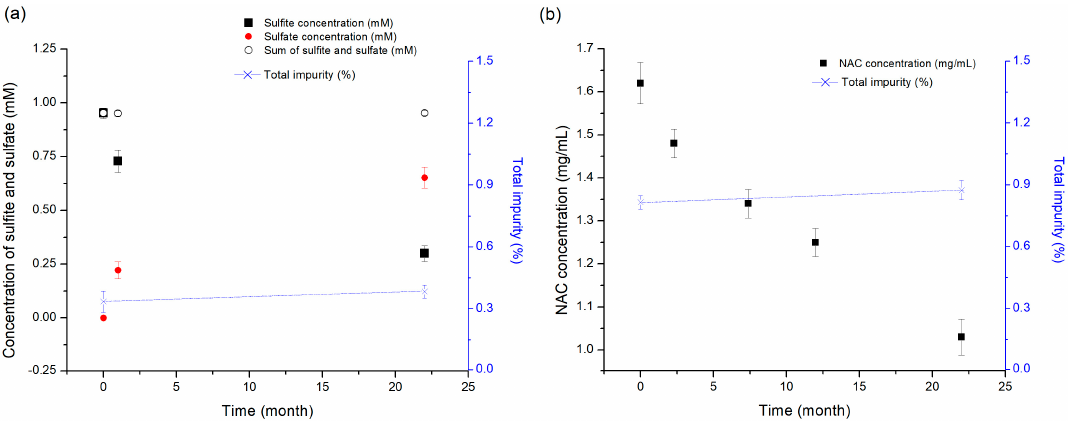
Figure 4. Ability of sodium sulfite (0.12 mg/mL) and NAC (1.63 mg/mL) as sacrificial reductants (25 °C for 22 months): ( a ) changes in total impurity ( ╳ ) and in concentrations of sulfite ( ■ ), oxidized sulfate ( ● ) and their sum ( ○ ), with storage period; ( b ) changes in total impurity ( ╳ ) and in concentrations of NAC ( ■ ) with storage period.